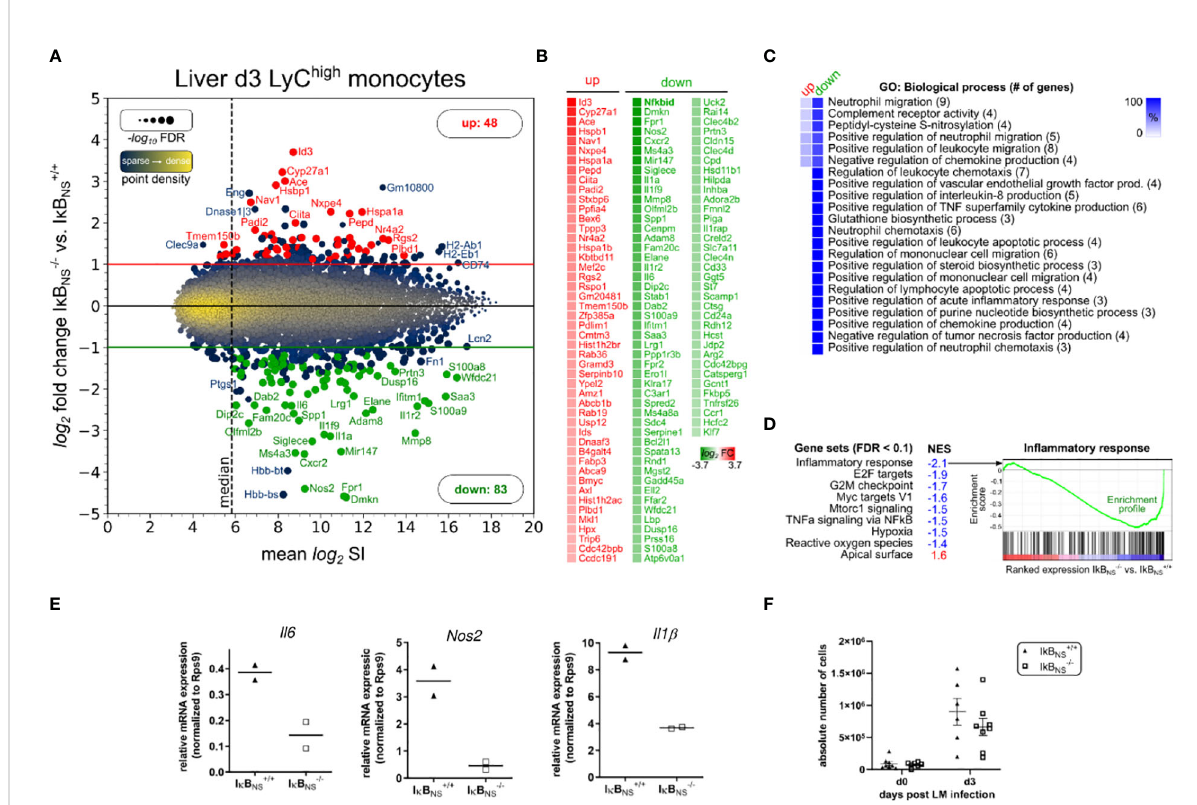
FIGURE 4 Transcriptome analysis of Ly6C high monocytes sorted from I k B NS-/- and wild type livers 3 days post Lm infection. WT and I k B NS-/- mice (n = 3-5 per group, from two independent experiments) were infected with 3×10 4 CFU LM i.v., sacri fi ced on day 3 post infection, liver tissue was enzymatically digested, total leukocytes were isolated using Percoll density gradient centrifugation, Ly6C high in fl ammatory monocytes were FACS sorted and pooled per genotype and total RNA was isolated. Transcriptome was analyzed using Affymetrix Clariom S microarray comparing I k B NS-/- to I k B NS+/+ monocytes. Differential expression was determined by applying fold change threshold > 2-fold with FDR < 0.05, resulting in 131 signi fi cantly regulated transcripts. (A) Ratio-Average plot. Number of up/down regulated transcripts are stated and selected gene symbols (up: red, down: green, blue: otherwise) are shown. (B) Gene symbol list of regulated transcripts ranked by log 2 fold change. (C) Gene ontology (GO) enrichment analysis for GO category “ Biological process ” showing terms with FDR < 0.05 and GO level ≥ 8. Percent of genes in reference to the total number of mapped genes within overrepresented GO terms were calculated, hierarchically sorted and color coded for the group of up/down regulated transcripts. Total number of mapped genes per GO term is stated in brackets. (D) Gene Set Enrichment analysis of expression-ranked (I k B NS-/- vs. I k B NS+/+ ) list of all 22206 transcripts on the microarray for hallmark gene sets with FDR < 0.1. NES: normalized enrichment score. (E) qRT-Real-time PCR of Il-6 , Nos2 and Il-1b normalized to Rps9 expression. (F) Absolute cell counts of CD11b + Ly6C high in fl ammatory monocytes in livers of uninfected and day 3 LM infected I k B NS-/- and I k B NS+/+ mice (n = 6-8). Data are from two independent experiments. Mean ± SEM is